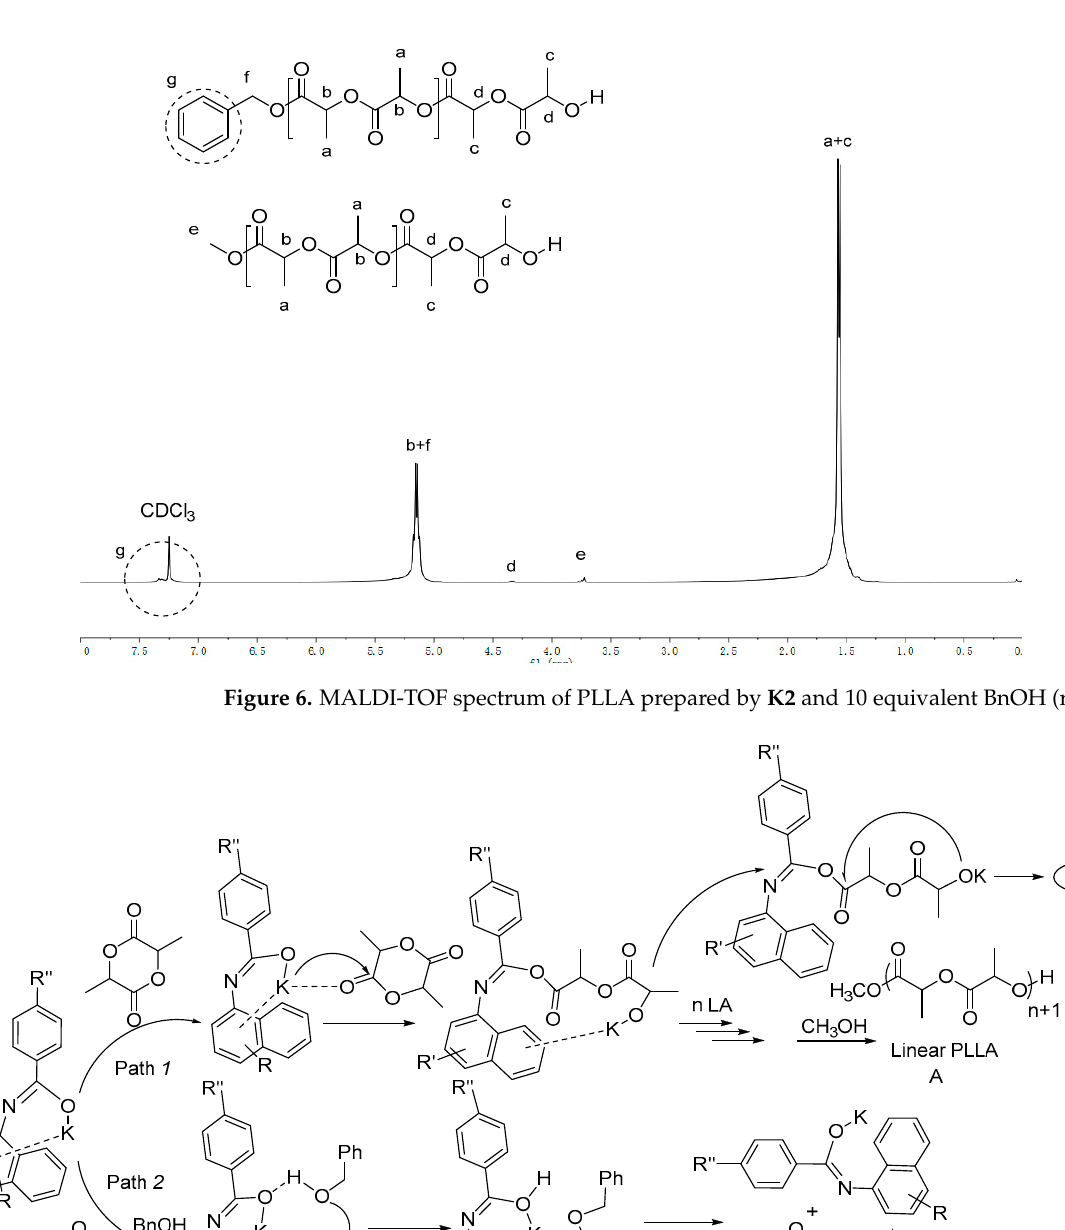
Figure 5. MALDI-TOF spectrum of PLLA obtained by K2 and 10 equiv. BnOH (run 9, Table 2).